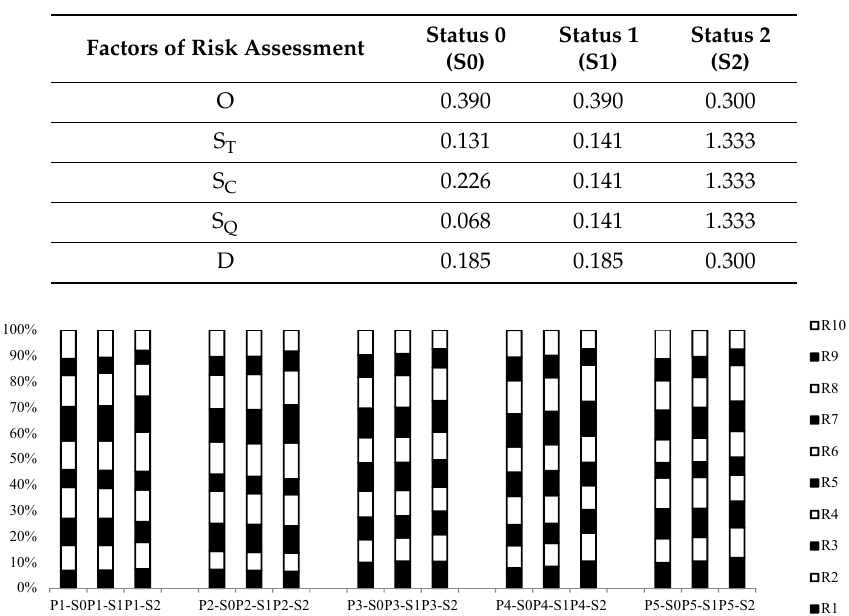
Figure 7. Sensitivity analysis for 5 investment projects. Source: Authors’ elaboration.